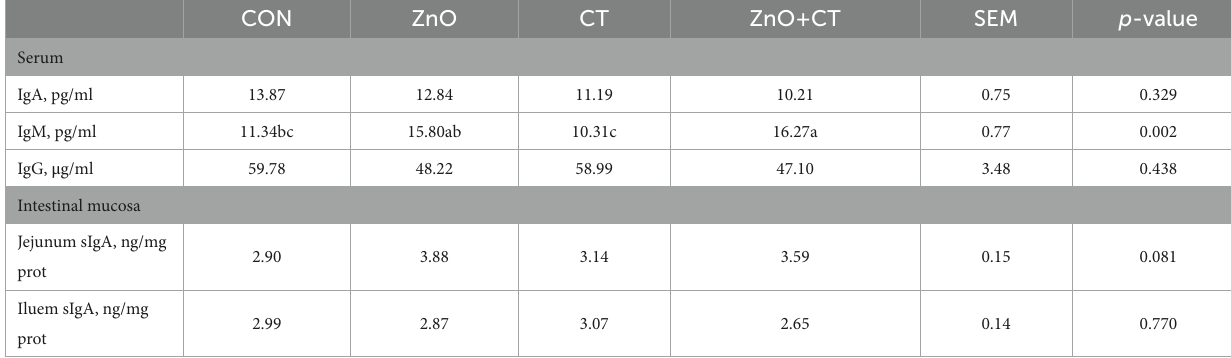
TABLE 2 Effects of ZnO and CT on immunoglobulin contents in serum and intestinal mucosa of weaned piglets in K88-challenged environment.